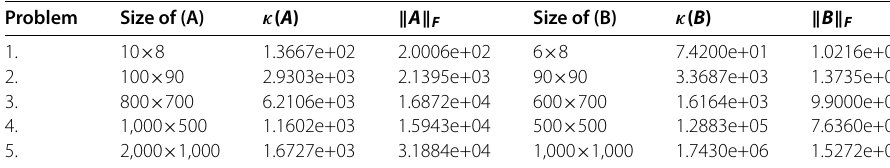
Table 1 Description of test problems